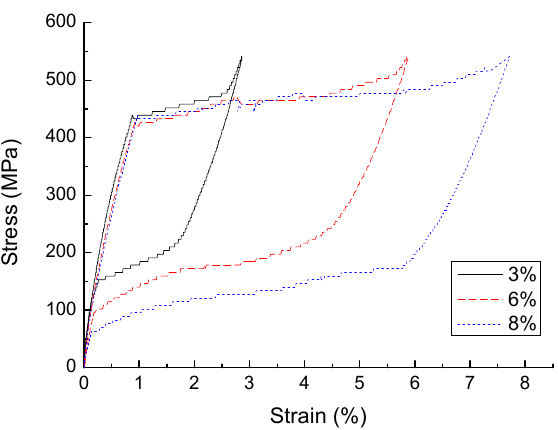
Figure 3. Stress-strain curve of austenite SMA wire with different strain amplitudes. Table 2. Mechanical properties of SMA wires with different strain amplitudes. Strain Amplitudes